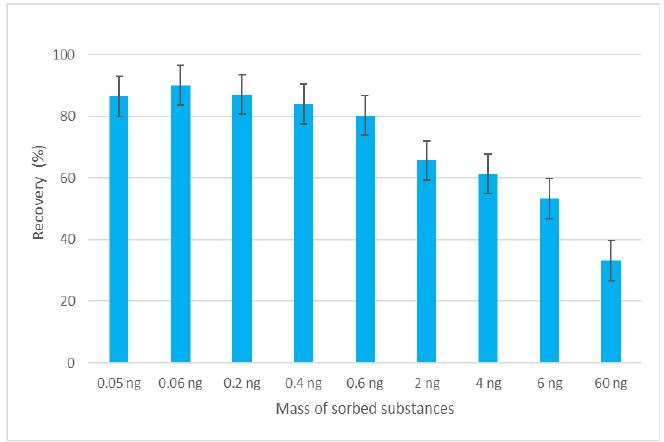
Figure 3. Dependence of recovery of EGDN on the mass of sorbed substances.